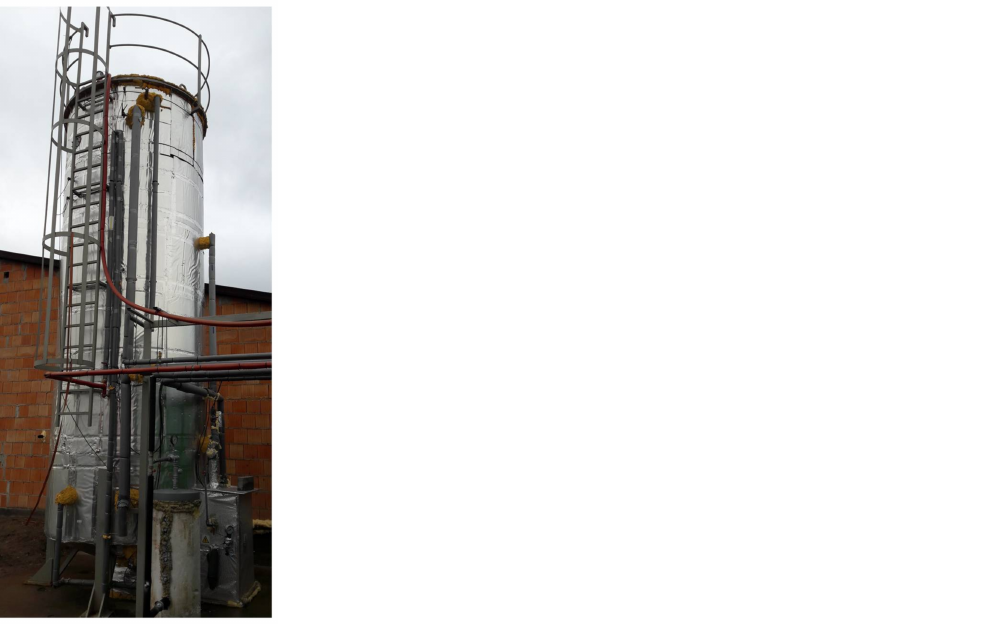
Figure 8. Monosubstrate flow reactor for methane fermentation of slurry with a biogas production installation-view (photo by Grzegorz Wałowski).